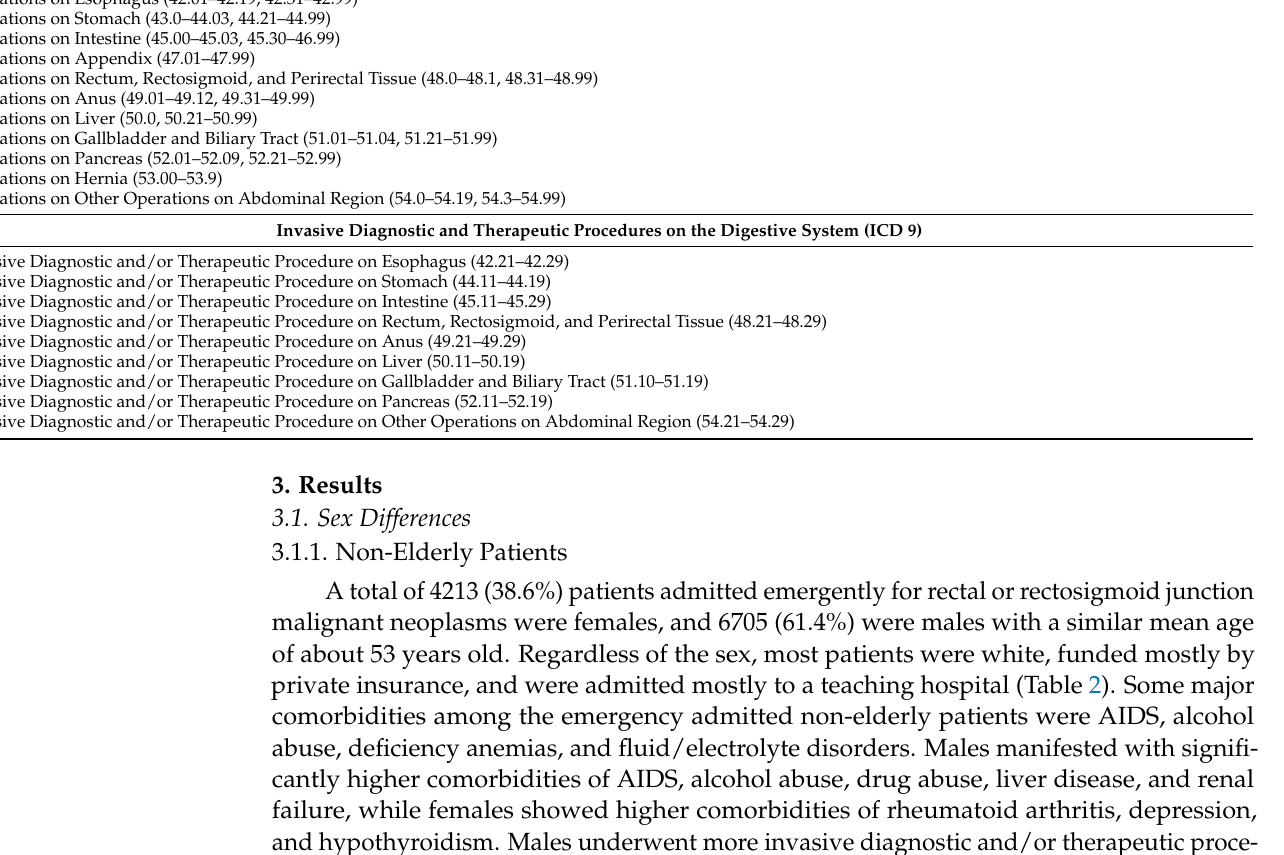
Table 1. Procedures of emergency admitted patients with the primary diagnosis of rectum or rectosigmoid junction. Operations on the Digestive System (ICD